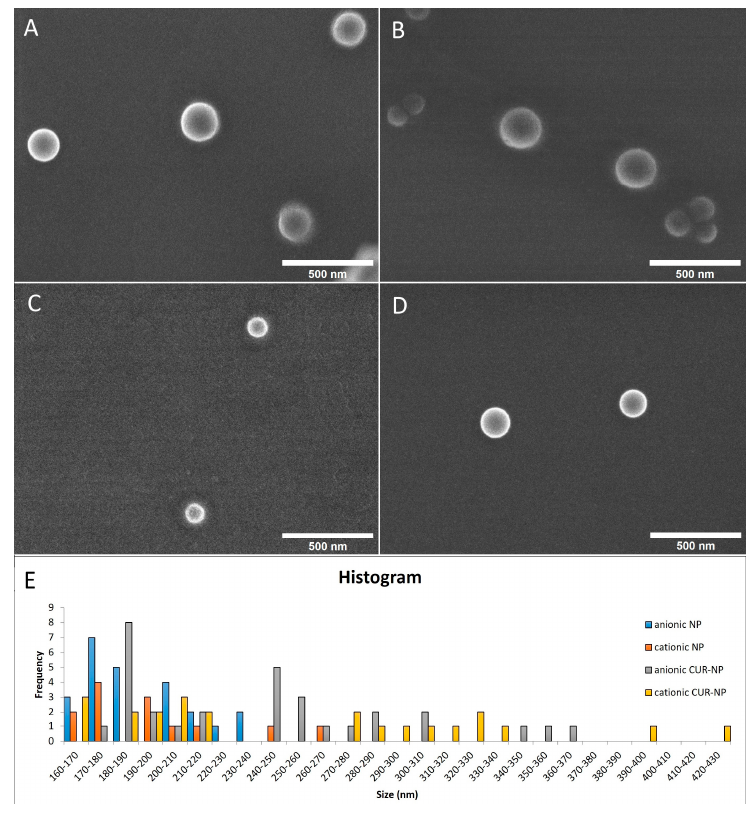
Figure 1. FEG-SEM of NP formulations with and without CUR: ( A ) anionic CUR-NP (magnification: × 60,000); ( B ) cationic CUR-NP (magnification: × 60,000); ( C ) anionic NP without CUR (magnification: × 60,000); ( D ) cationic NP without CUR (magnification: × 60,000); and ( E ) histogram showing size of all